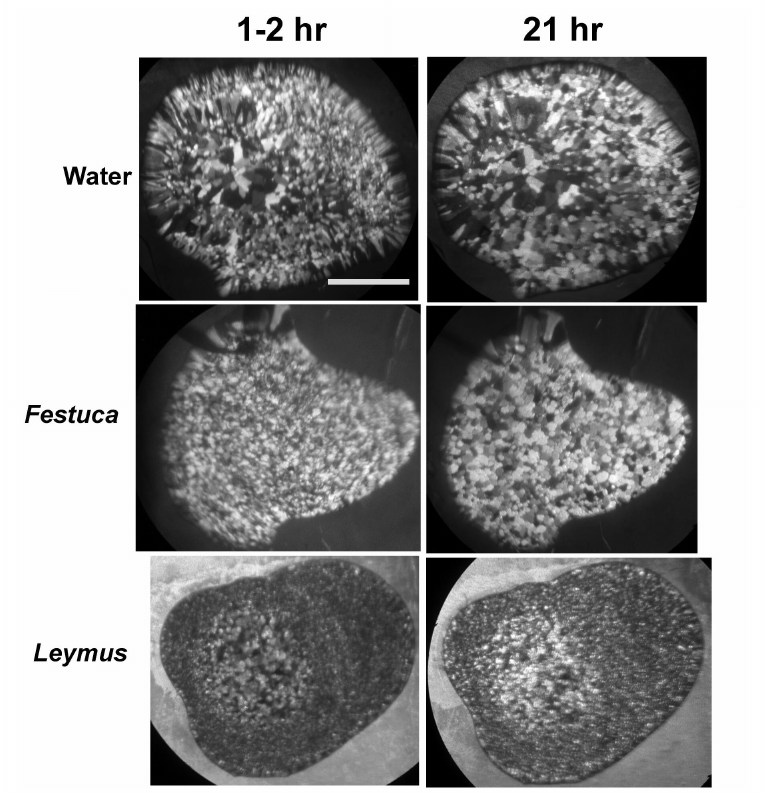
Figure 2. Comparison of ice recrystallization in 3 µl drops of water and extracts from lawn grass ( Festuca ) and L. mollis ( Leymus ). Scale bar, 1 mm.